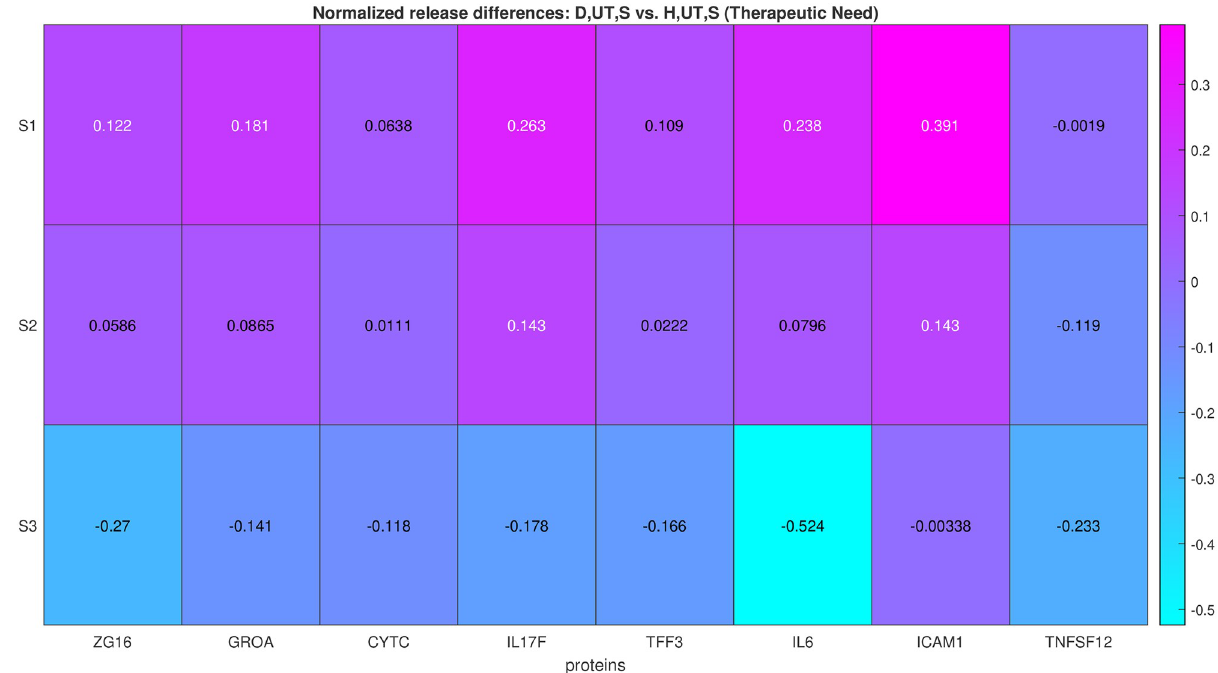
Fig 2. Therapeutic need quantification. Example showing the quantitative answers provided to question Q1b, using data from the OA case study presented later in this work. The external stimulations used, denoted S 1; S 2; S 3, are shown in the y -axis, while the proteins measured are shown in the x - axis. The value in each patch is quantified by employing Eq (2) in the context of answering question Q1b.